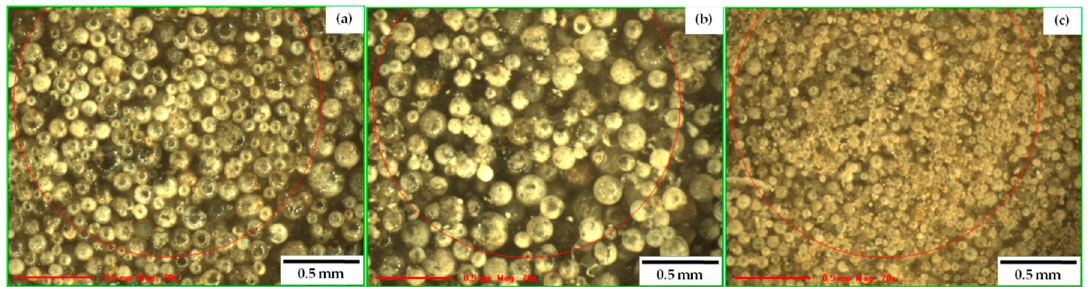
Figure 7. X-ray fluorescence (XRF) images of cenospheres collected from the freshly prepared mixtures at different acetone/water ratios of ( a ) 80:20, ( b ) 50:50, and ( c ) 20:80, using a fly ash/medium ratio of 1:5 and a 4-h soaking period.